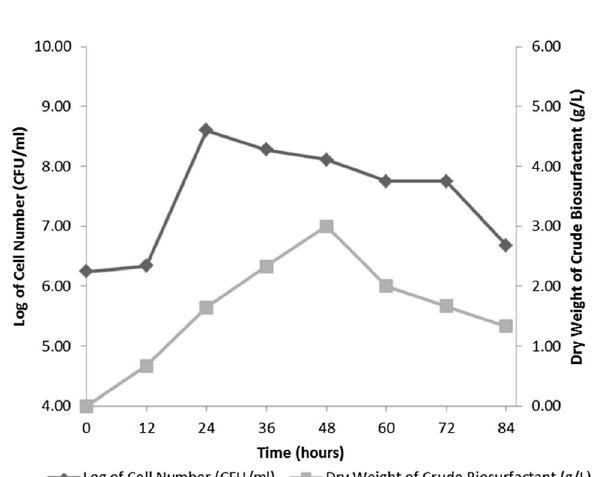
Fig. 3 Growth biosurfactant production curve by Pseudoxan- thomonas sp. G3 at different incubation times